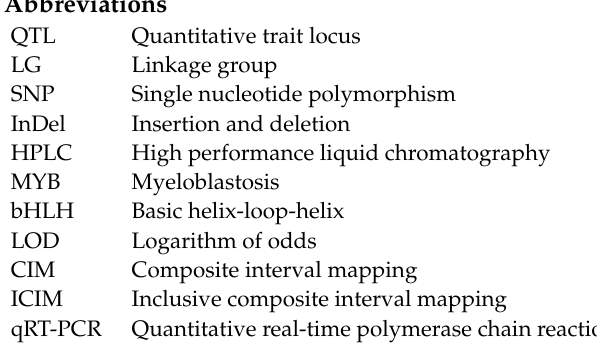
Table S4: List of potential candidate genes in the major QTL related to radish flowering and bolting times